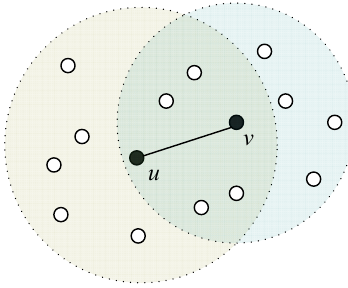
Figure 3. Interference before adjusting the transmission range.